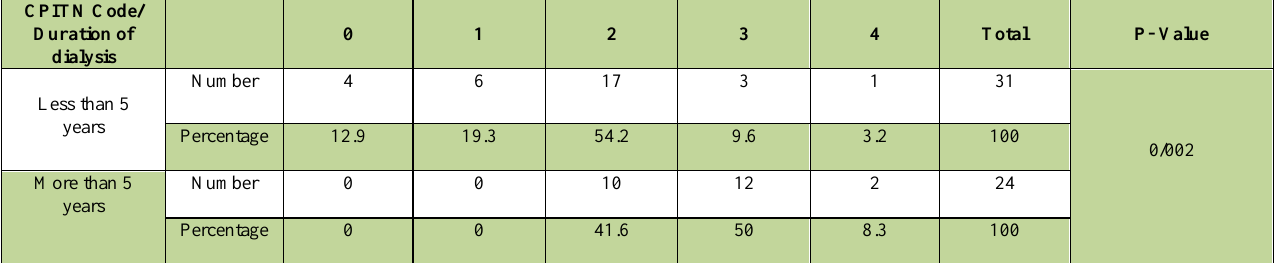
Table 5. Distribution of CPITN index in subjects studied by the duration of dialysis.